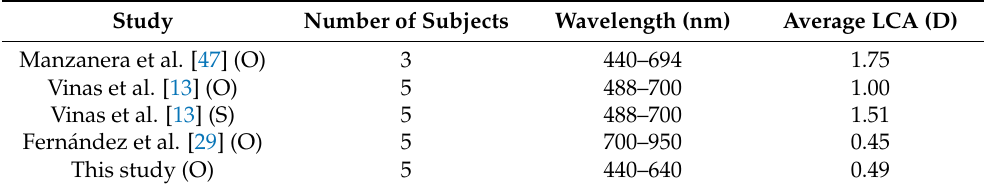
Table 3. Comparison of the results obtained with different techniques established in the literature (S: subjective method, O: objective